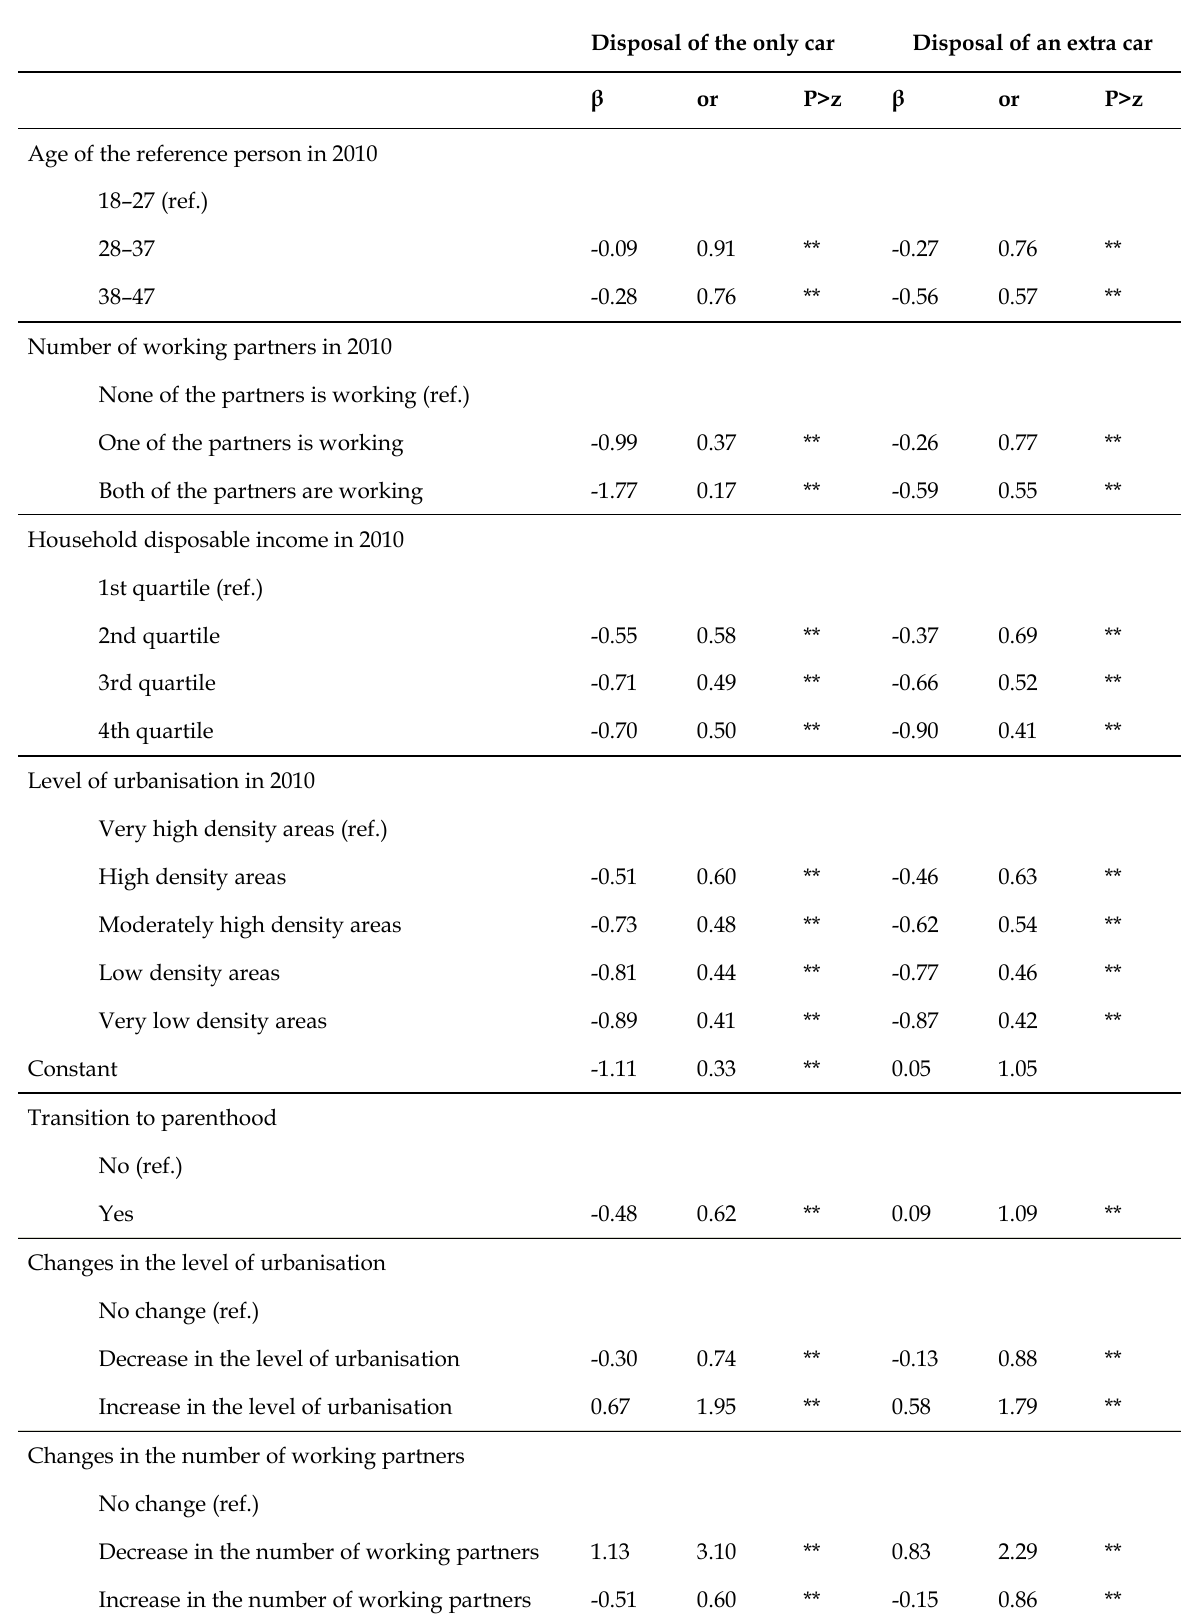
Table 3. Relationship between car disposal and entry into parenthood, residential relocation and changes in employment status and